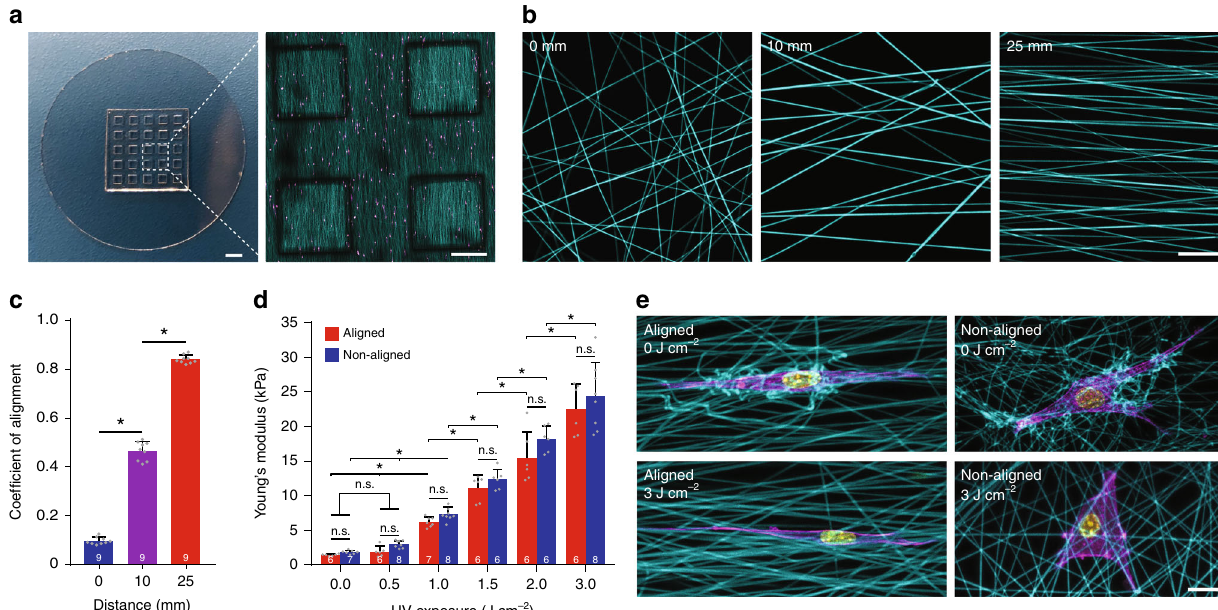
Fig. 1 Synthetic fi brous extracellular matrix with orthogonal control over fi bril alignment and stiffness. a Microfabricated poly(dimethylsiloxane) multiwell substrate possessing a 5 × 5 array of DexMA fi ber matrices, each suspended over a well to isolate the matrix from mechanical effects of a rigid underlying support (scale bar: 2 mm). Inset: tilescan of four DexMA-cRGD matrices (cyan) seeded with NIH3T3 fi broblasts (magenta) (scale bar: 500 µ m). b Confocal projections of matrices (cyan) fabricated with varying spacing between collecting electrodes to modulate fi ber alignment (scale bar: 20 µ m). c Quanti fi cation of fi ber alignment as a function of electrode separation distance ( n = 9 matrices per group). d Young ’ s modulus of aligned (electrode separation of 0 mm) and non-aligned (electrode separation of 25 mm) matrices as a function of ultraviolet (UV)-initiated crosslinking of matrix fi bers. n = number of matrices per group as indicated within each bar. e Composite confocal fl uorescence images of representative NIH3T3 fi broblasts in soft (top row, 0 J cm − 2 ) and stiff (bottom row, 3 J cm − 2 ) matrices; rhodamine-labeled matrix fi bers (cyan), F-actin (magenta), and nuclei (yellow) (scale bar: 20 µ m). All data presented as mean ± s.d.; * indicates a statistically signi fi cant comparison with p < 0.05; n.s. indicates a non-signi fi cant